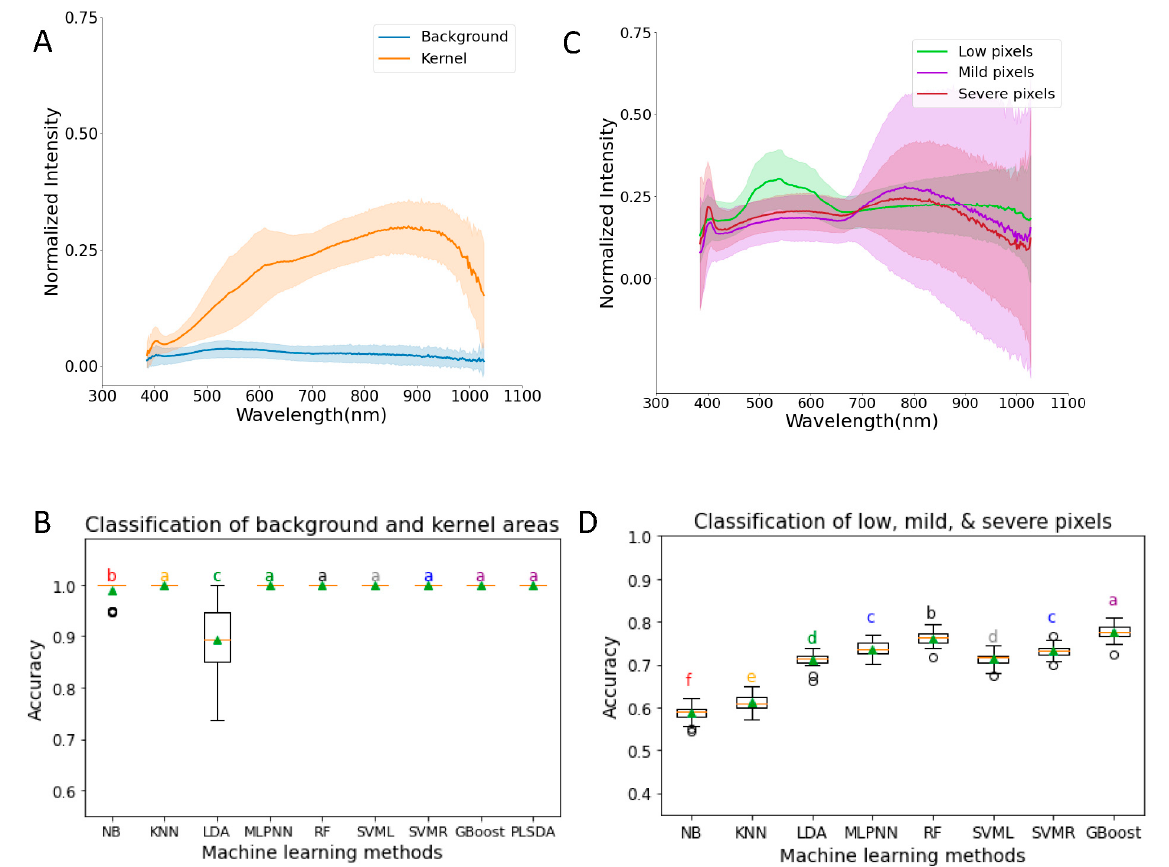
Figure 2. ( A ) Spectral profile of background and kernel areas. ( B ) Comparison of the performance of nine machine learning methods to classify data points into background and kernel areas. ( C ) Spectral profiles of low, mild, and severe pixels. ( D ) Comparison of the performance of eight machine learning methods to classify pixel data points into low, mild, and severe classes. NB = Gaussian Naïve Bayes; KNN = K-nearest neighbors; LDA = linear discriminant analysis; MLPNN = multi-layer perceptron neural network; RF = random forests; SVML = support vector machine with linear kernel; SVMR = support vector machine with radial basis function kernel; G-Boost = gradient boosting; PLSDA = Partial Least Squares Discriminant Analysis. All data in ( A , C ) are normalized with a maximum value of 1.0. Letters a–f in ( B , D ) indicate statistical test results with same letter representing that the difference is not statistically